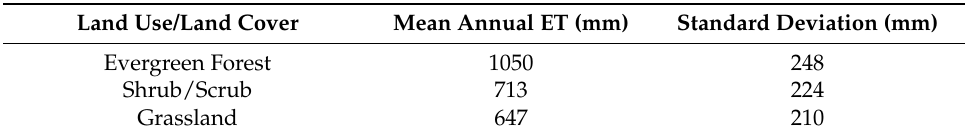
Table 2. Annual evapotranspiration (mm) from MOD-SMET during 2013 for top three National Land Cover Database [40] land use/land cover within the study